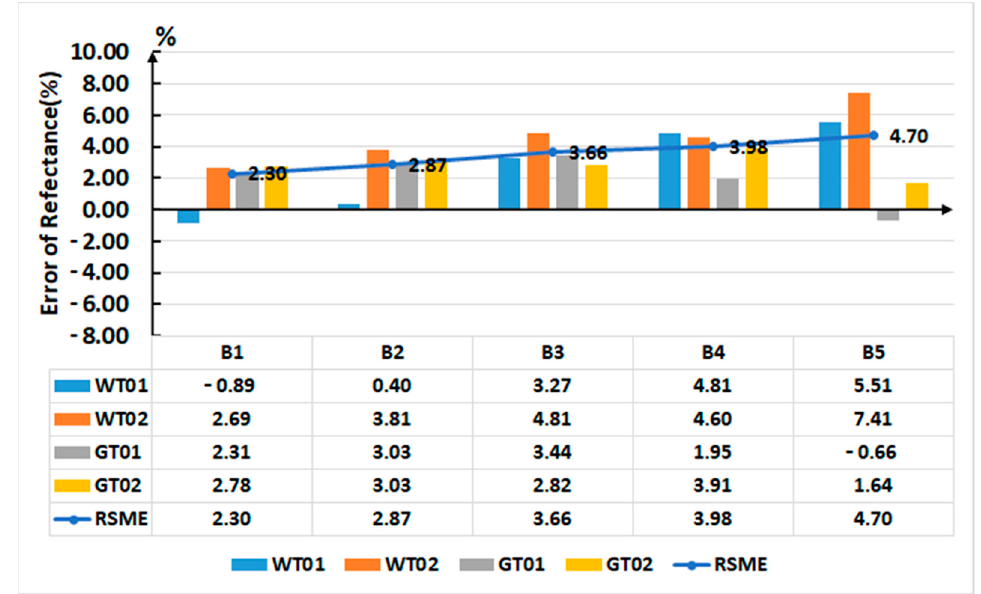
Figure 22. Error of reflectance of targets in five spectral images corrected by the LUT method.